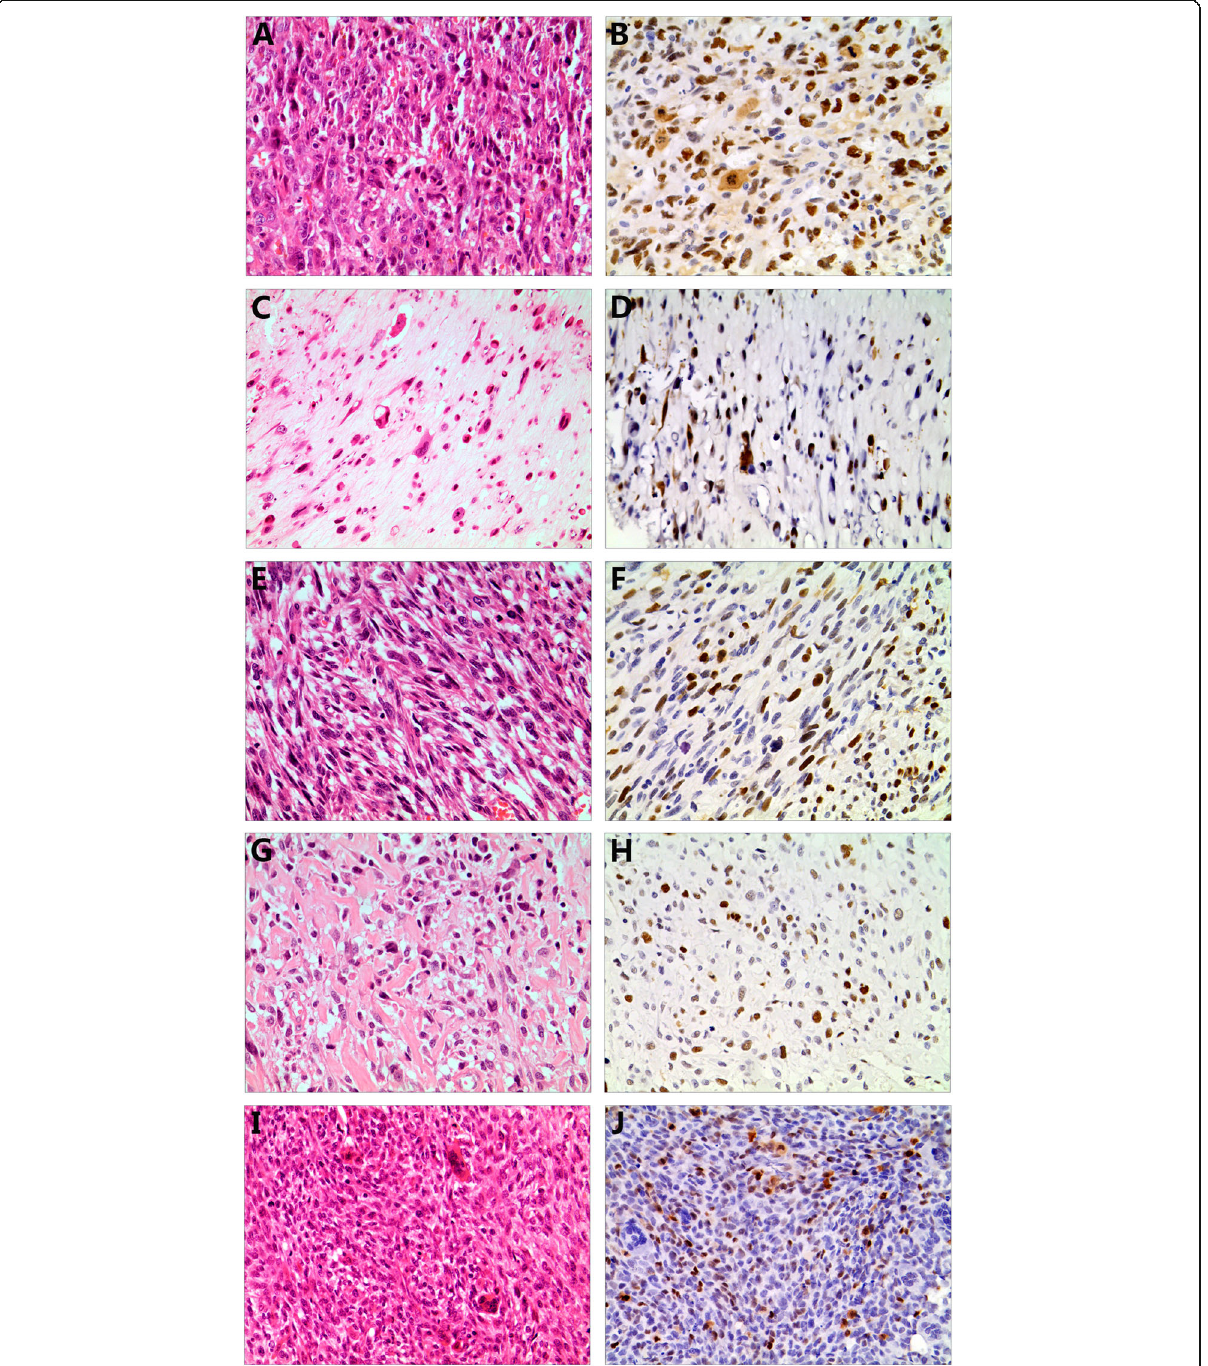
Fig. 3 KPNA2 expression in subtypes of osteosarcoma. Osteoblastic ( a ), chondroblastic ( c ), fibroblastic ( e ), telangiectatic ( g ) and giant cell-rich osteosarcoma ( i ) samples were positive for KPNA2. ( a – j ×